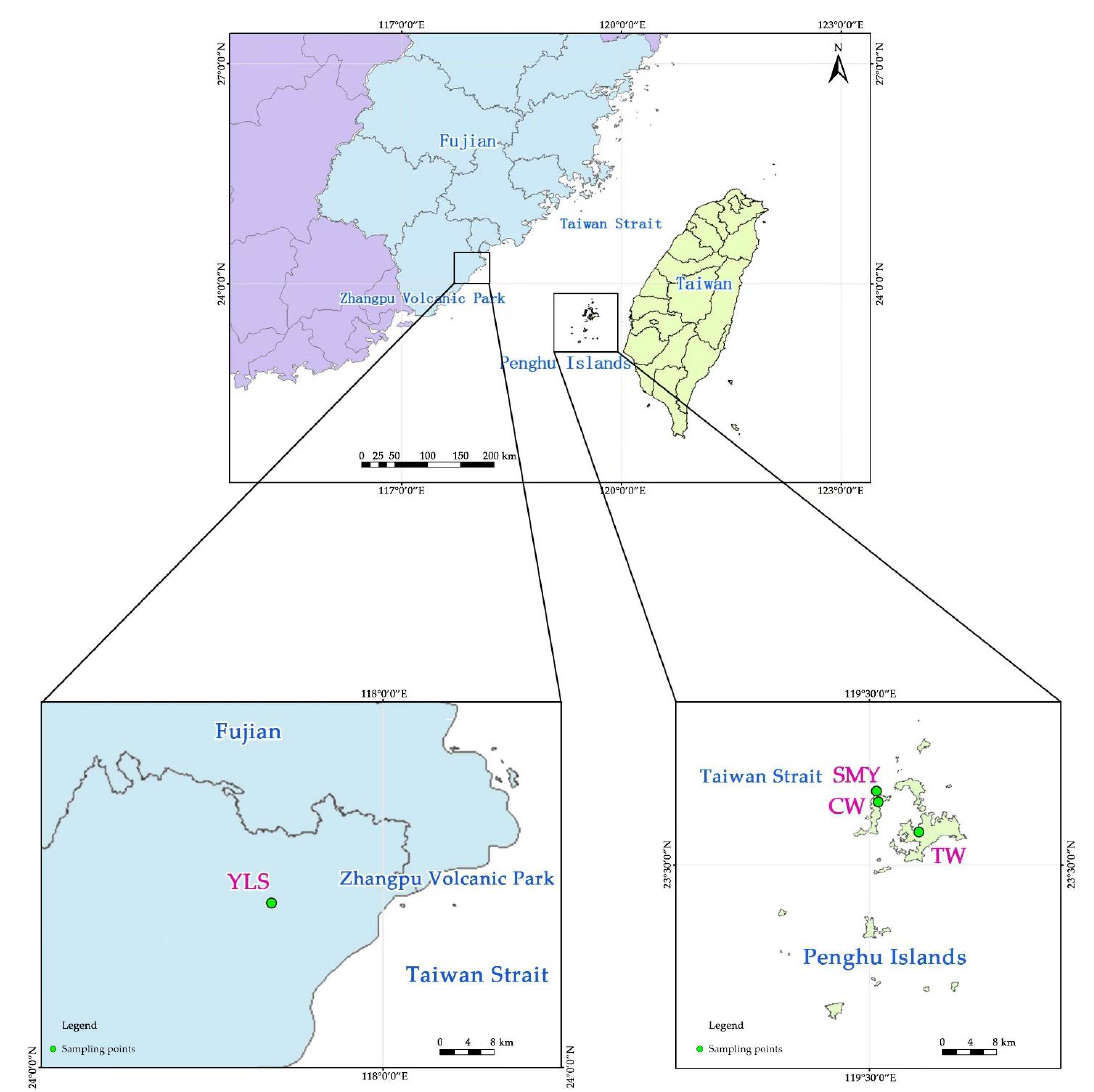
Figure 2. The distance between the Penghu Islands and Zhangpu volcanic area is approximately 180 km. The Penghu Islands are located on the east side of Zhangpu volcanic area. CW: Chu Wan; SMY: Shiao Men Yu; TW: Tong Wei (Penghu); YLS: Yulinshi